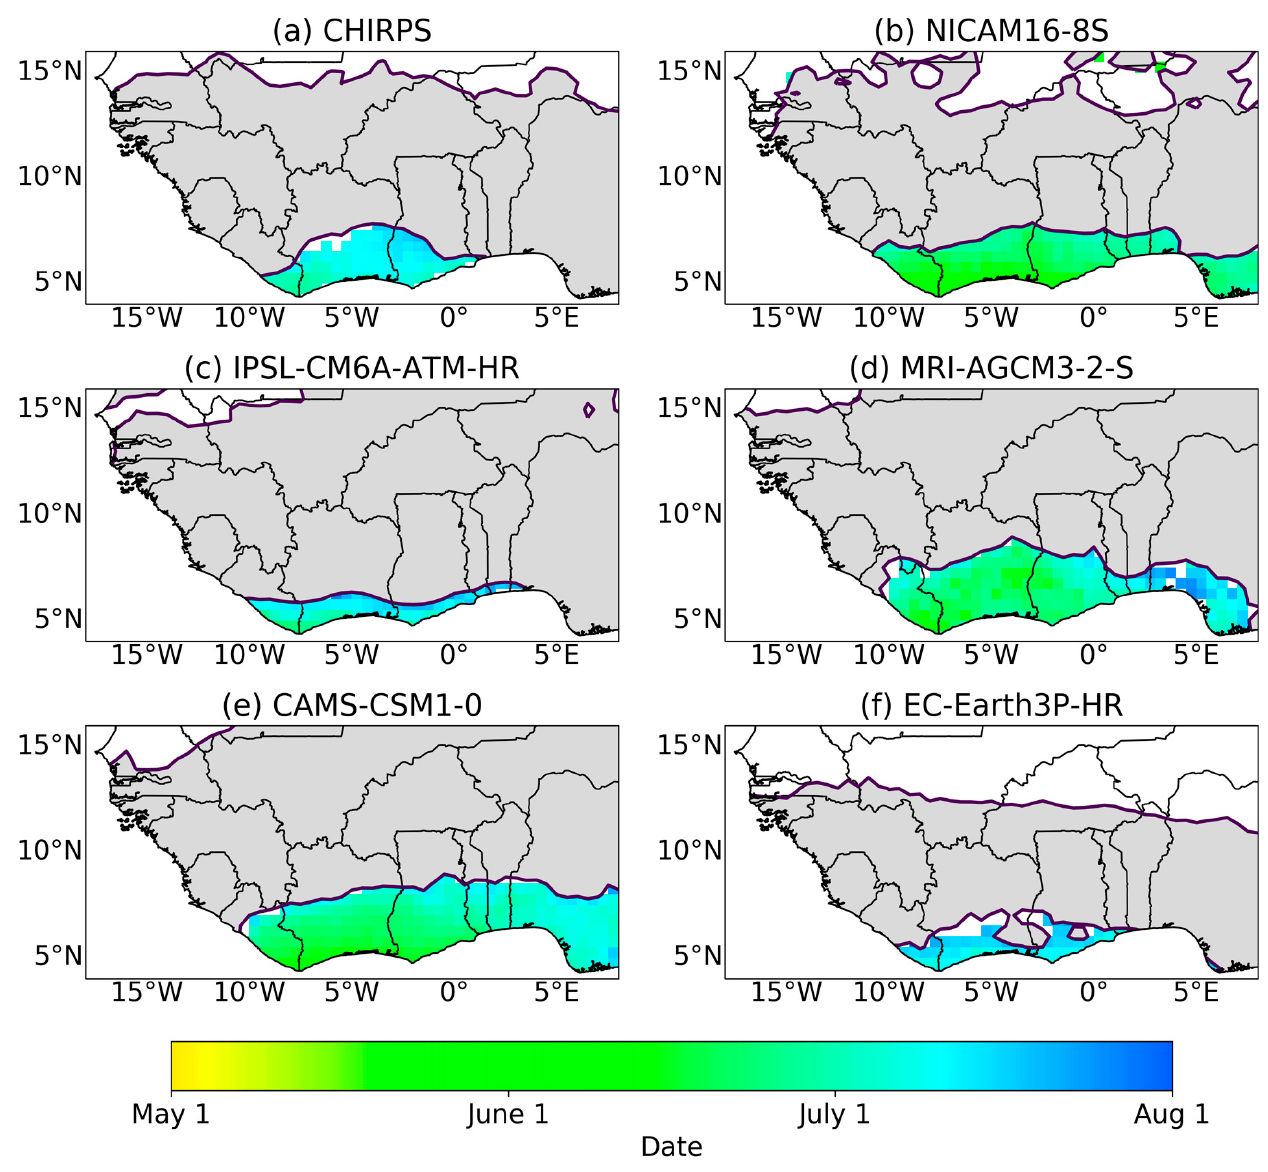
Figure 6. Mean cessation date for first (major) rains for all data sets. Dark grey indicates regions with a unimodal regime and white indicates dry regions.